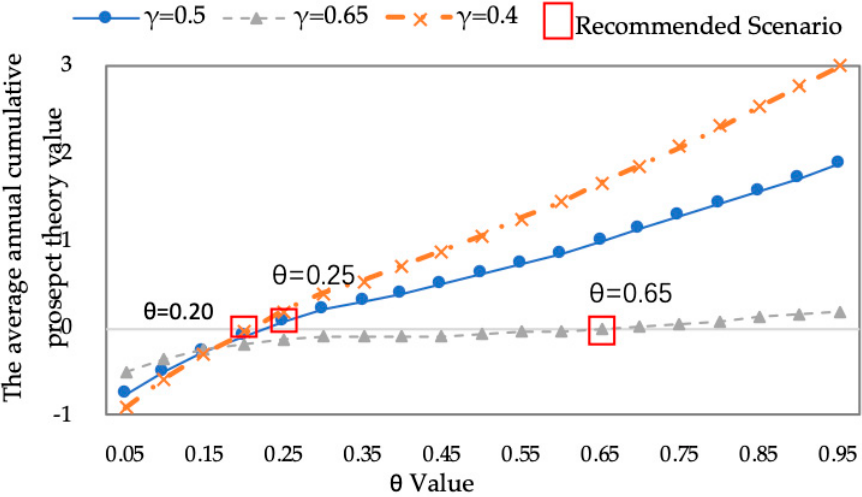
Figure 10. The recommended scenarios for di ff erent decision weights γ of